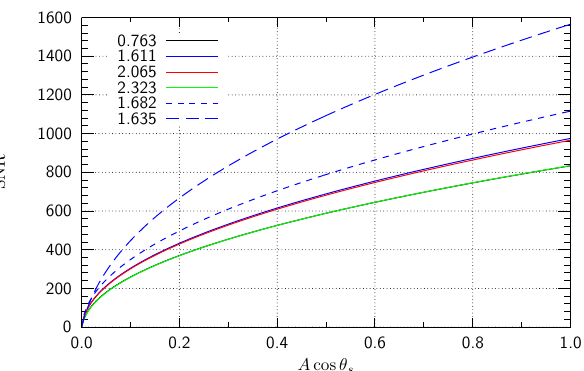
Fig. 4. SNR as a function of A cos θ s for the baseline configuration (solid colours) and for the descope options (dashed). The curves for the bands at 0.763µm and 2.323µm by chance are so close as to be = N 1 I . The table shows 0